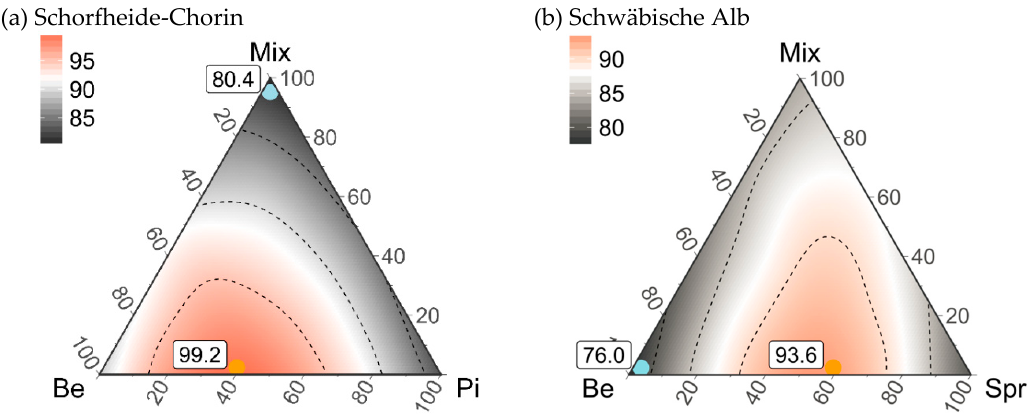
Figure A7. Regional diversity (Shannon diversity) in % for ( a ) Schorfheide-Chorin and ( b ) Schwäbische Alb combining vascular plants, bryophytes and lichens along compositional gradients of pure beech (Be), pure conifer (Pi = Pine, Spr = Spruce) and mixed stands (Mix). The composition of stand types was varied in steps of 10% using 1000 resamplings of 22 plots per step for Schorfheide-Chorin and using 66 resamplings of 10 plots per step for Schwäbische Alb. The regional diversity quantifies the mean relative gamma diversity of taxonomic groups accounting for the absolute diversity within groups (log weighting of diversity). Labelled dots mark the maximum (orange) and minimum (light blue) regional diversity.